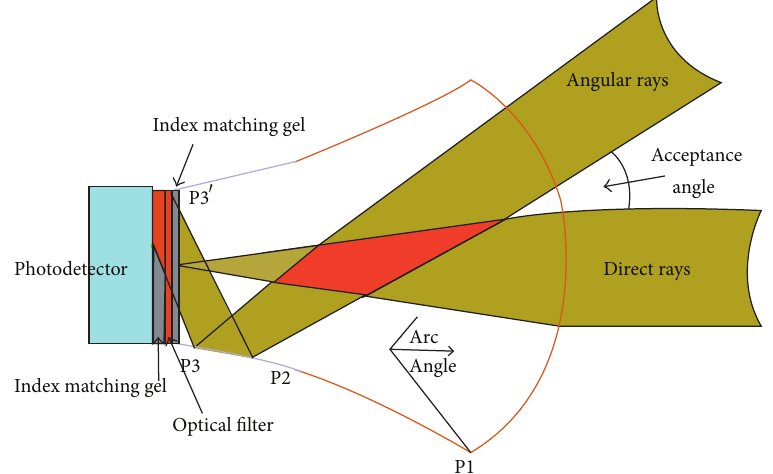
Figure 5: Side view of a DTIRC [81].